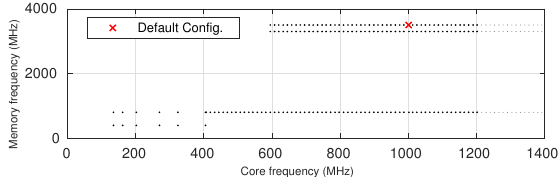
Figure 2. Supported combinations of memory and core